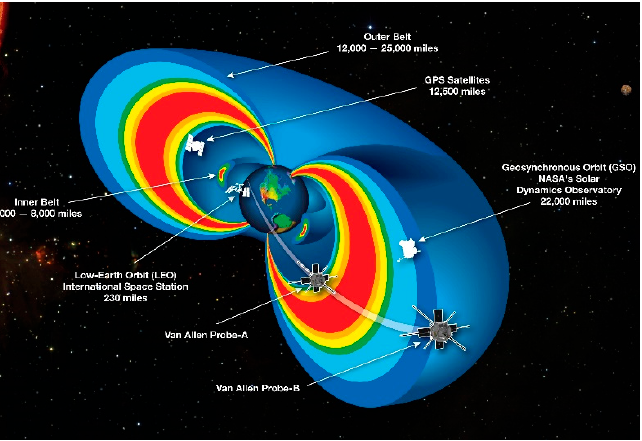
Figure 3. Pictorial of space radiation effects in the magnetosphere with a cut-away model. https://en. m.wikipedia.org/wiki/File:Van_Allen_Radiation_Belt_Model_shown_with_2_VA_Probes.jpg (ac- cessed date 29 January 2022).